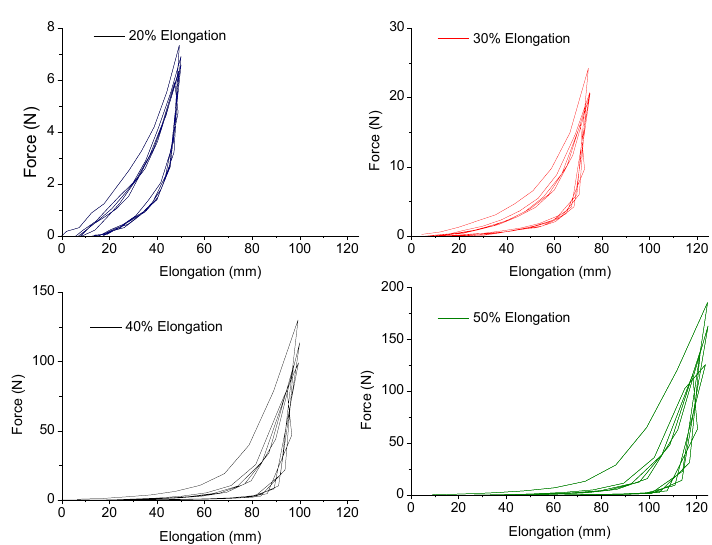
Figure 6. Recovery elasticity of knitted samples made of 100% bicomponent filaments.